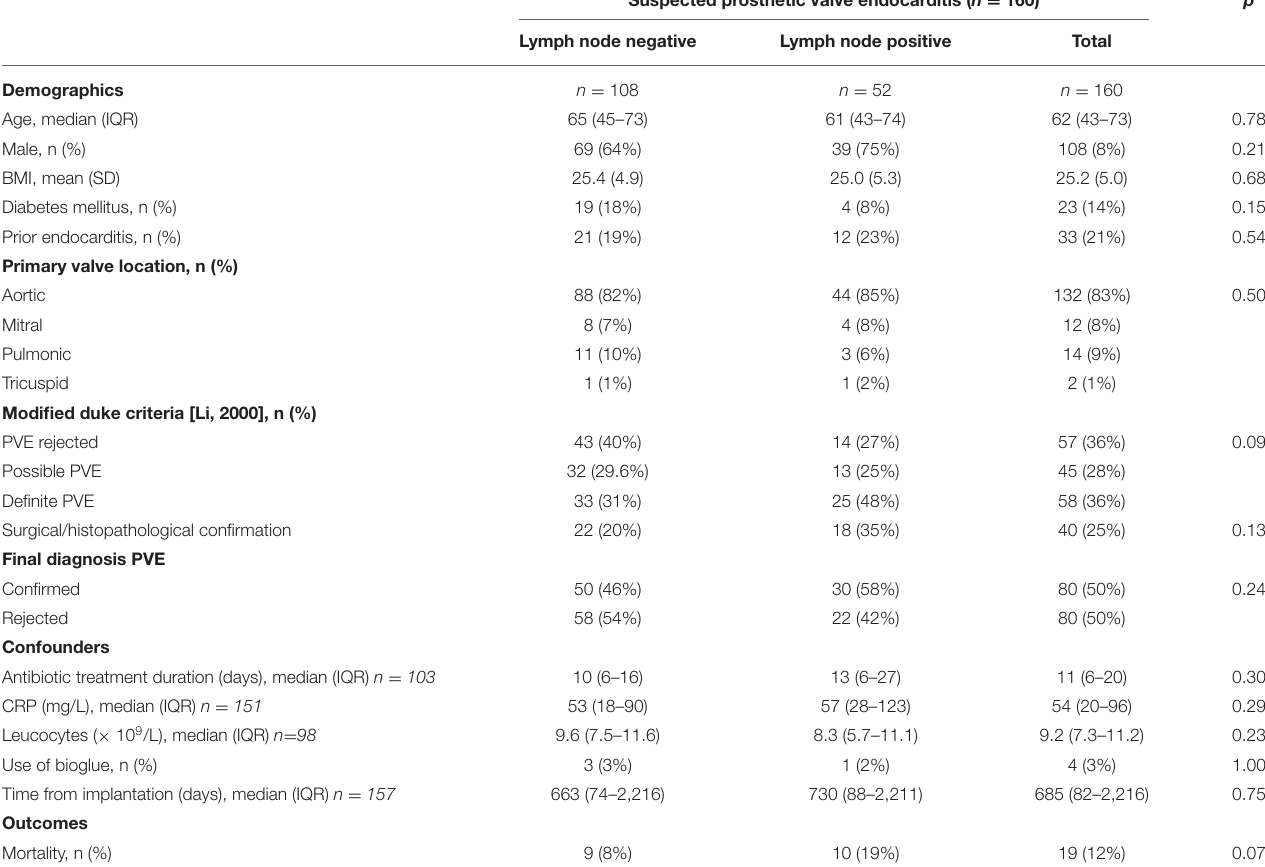
TABLE 1 | Demographic